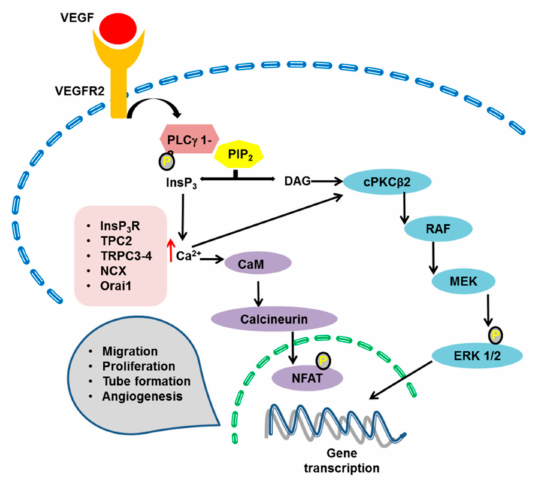
Figure 2. Ca 2 + -dependent activation of the extracellular signal-regulated kinase (ERK) pathway and of the Nuclear Factor of Activated T-cells (NFAT). VEGF binding to VEGFR2 triggers an increase in intracellular Ca 2 + concentration that may stimulate the ERK1 / 2 phosphorylation cascade or NFAT nuclear translocation. VEGF-induced endothelial Ca 2 + signals may be mediated by multiple Ca 2 + -entry / release pathways, depending on species and vascular bed. The Ca 2 + response to VEGF may recruit the Ca 2 + -dependent PKC β 2 (cPKC β 2), which engages the downstream RAF1–MEK–ERK1 / 2 cascade to induce gene expression. An increase in [Ca 2 + ] i is required to promote cPKC β 2 translocation to the plasma membrane, where it is activated by DAG. Moreover, VEGF-induced endothelial Ca 2 + signals may be sensed by calmodulin (CaM), which in turn activates calcineurin to dephosphorylate NFAT, thereby inducing its nuclear translocation. See Figure 1, Section 4.1 (ERK) and Section